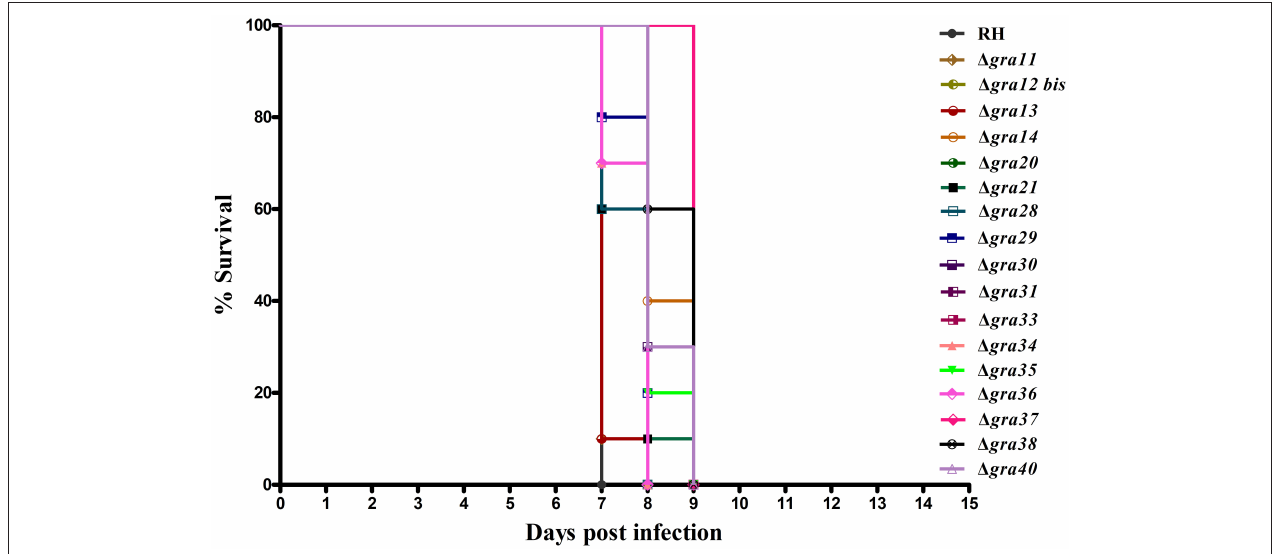
FIGURE 3 | Survival of BALB/c mice infected with Toxoplasma gondii wild-type or GRA -deficient RH strains. The mice were injected i.p., with 200 freshly harvested tachyzoites of the indicated strains. Ten mice were used per parasite strain. The survival time was recorded daily until all the mice have died within 7–9 days post